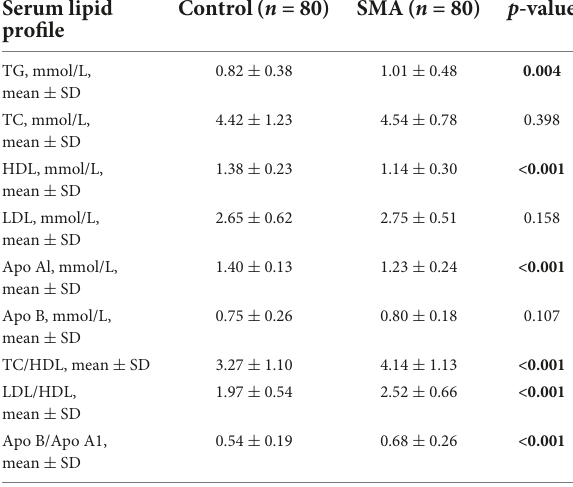
TABLE 3 Serum lipid profile levels of SMA and control